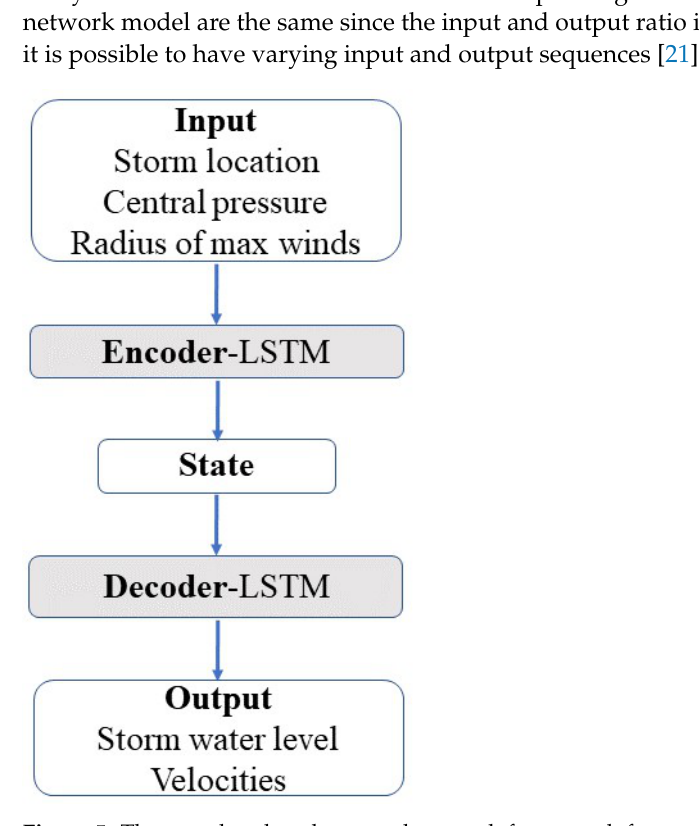
Figure 5. The encoder–decoder neural network framework for storm surge forecast. The encoder layer encodes the input into an internal state, and then the decoder layer decodes the internal state to the output. The input includes the storm center (longitude and latitude), the central pressure, and the radius of maximum winds, and the output includes storm-induced water level and velocity in the x and y directions. The LSTM model, a recurrent neural network, was used as the encoder and the